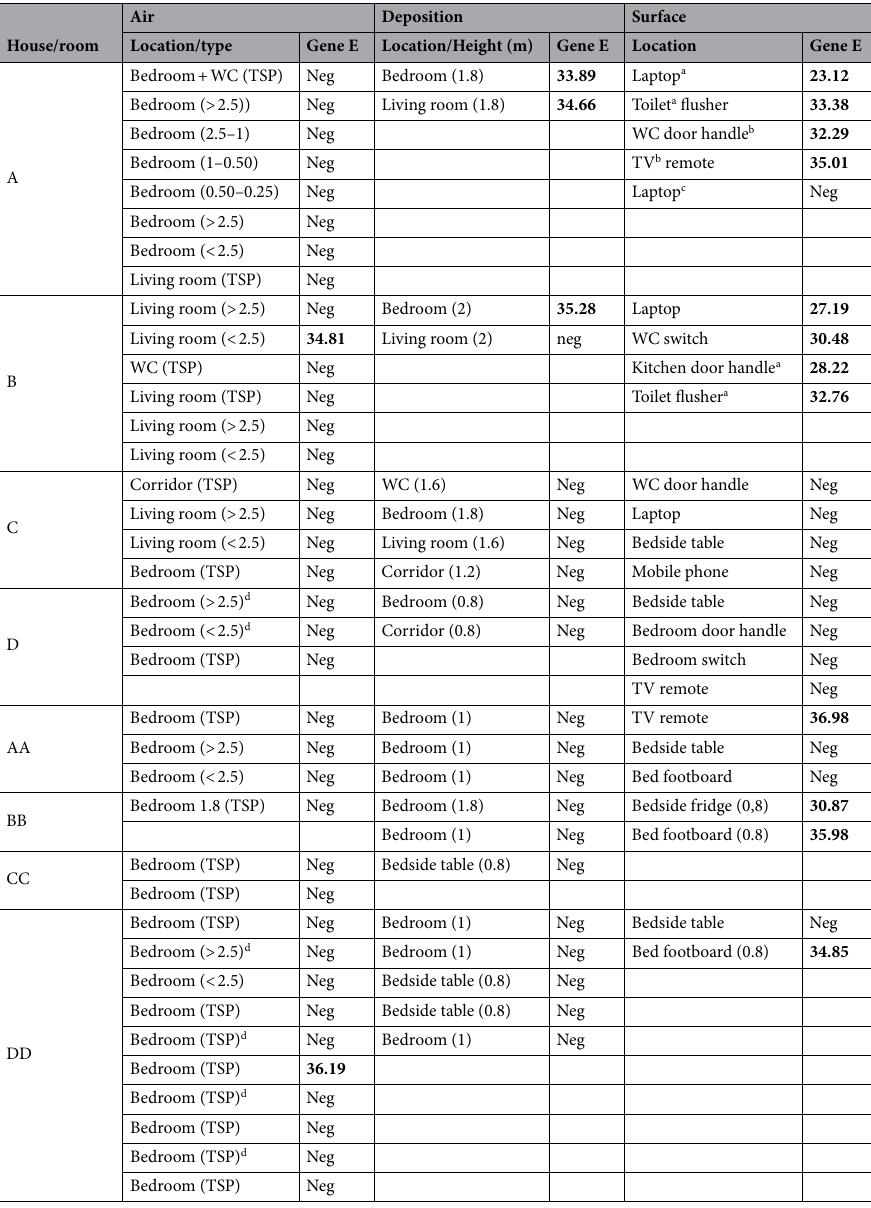
Table 1. Results from house sampling (houses A, B, C and D) and from nursing home sampling (rooms AA, BB, CC, DD). Gene E cycle threshold for RT-PCR, Neg negative result, undetected, TSP total suspended particles, > 2.5 impactor sample from stage A, < 2.5 impactor sample from stage B + C + D. Significant values are given in bold. a Cotton. b Gauze. c PTFE filter. d Air samples used for viability